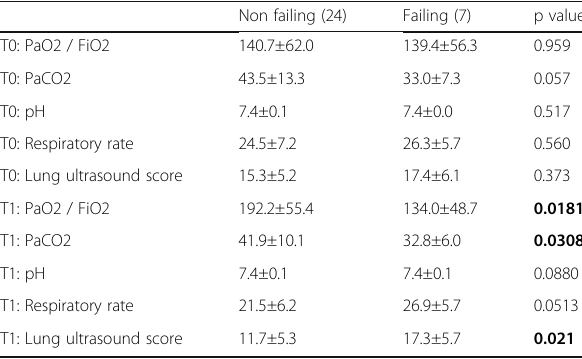
Table 1 (abstract 000351). Failing and non failing patients features before (T0) and after 2 hours (T1) of non-invasive respiratory